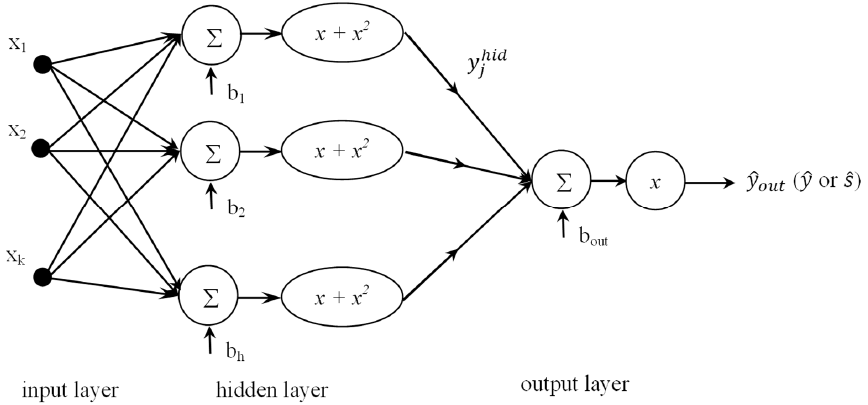
Figure 3. Functional-link-NN-based RD estimation method.